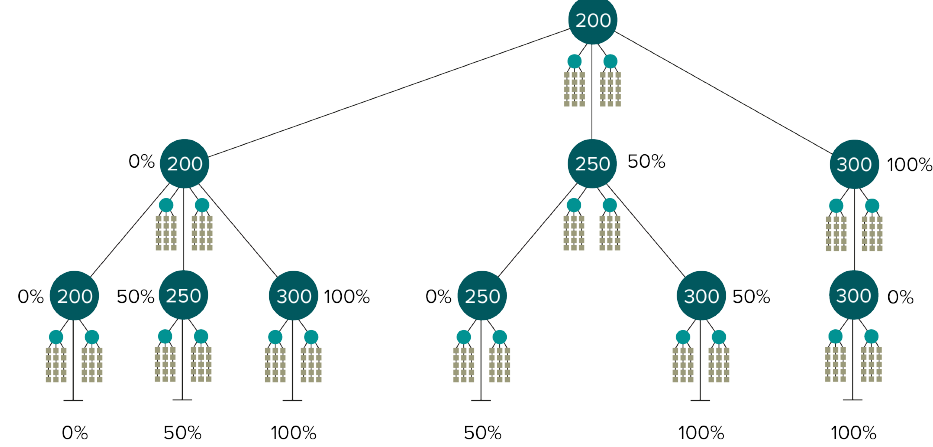
Figure 1. Scenario tree for instance F2, with uncertainty in the step-wise development of wind